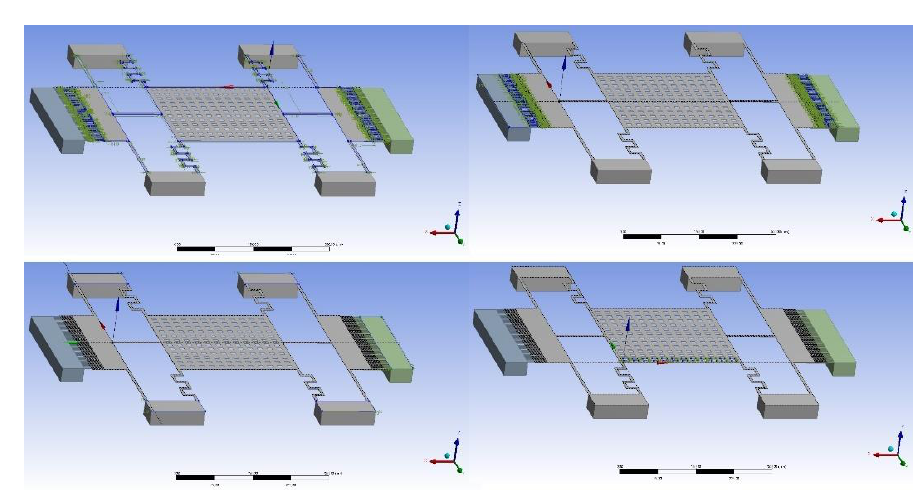
Fig. 4. Parametric 3D model of MEMS switch.